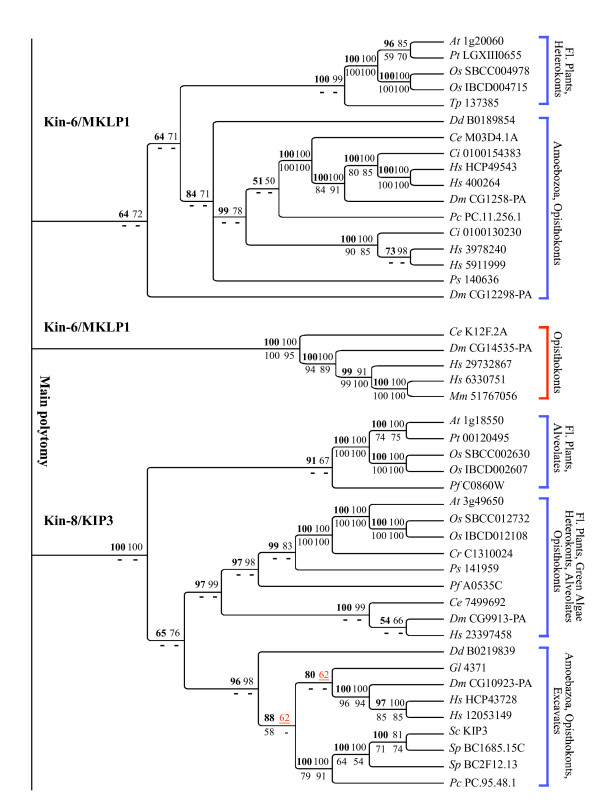
Expanded view of Kinesin-6 and Kinesin-8 families. Expansion of the Kinesin-6 and Kinesin-8 families from Fig. 2. Mixed clades are shown in blue brackets and red brackets indicate groupings composed of opisthokonts. See Fig. 2 legend for an explanation of support values. For full names of species see Fig. 1 legend. Fl. Plants, flowering plants.